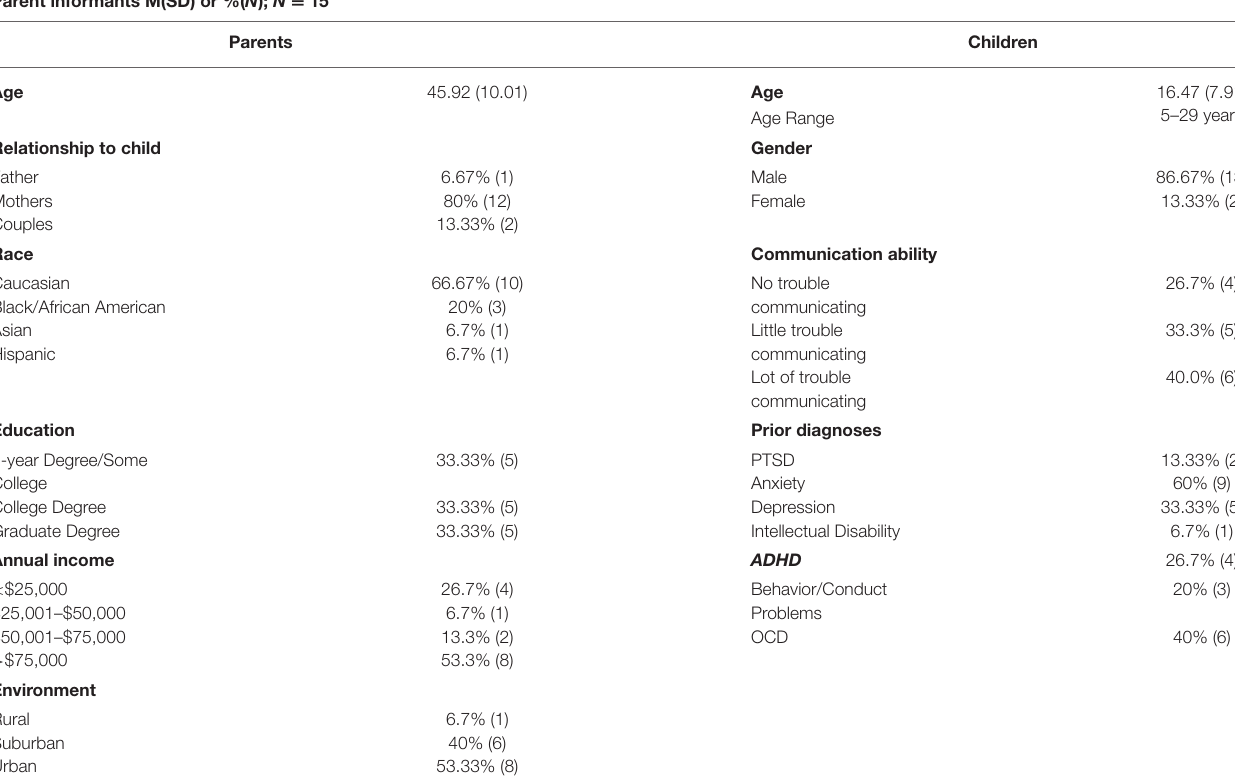
TABLE 2 | Characteristics of parent informants and their